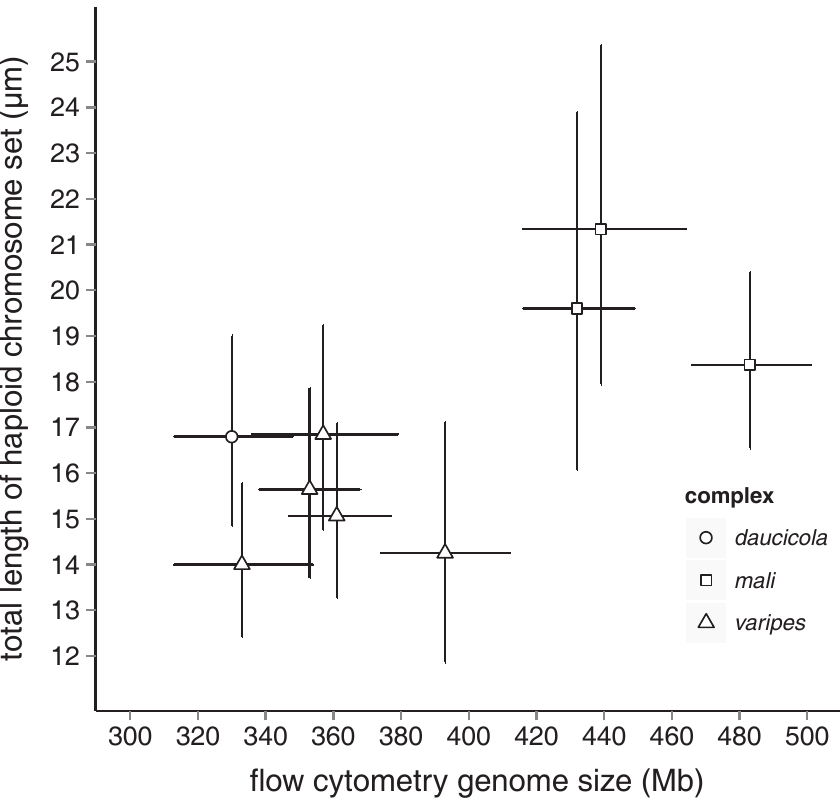
Figure 3. Total length of chromosome set (μm) versus flow cytometry genome size (Mb) for nine Aphe- linus species. Error bars are 95% confidence